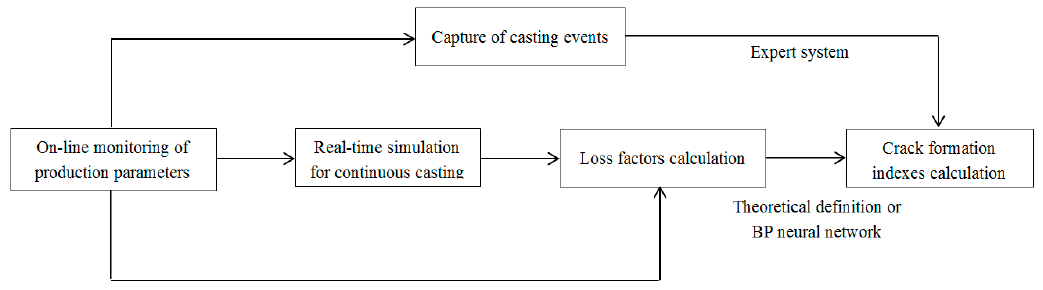
Figure 3. Model software function.